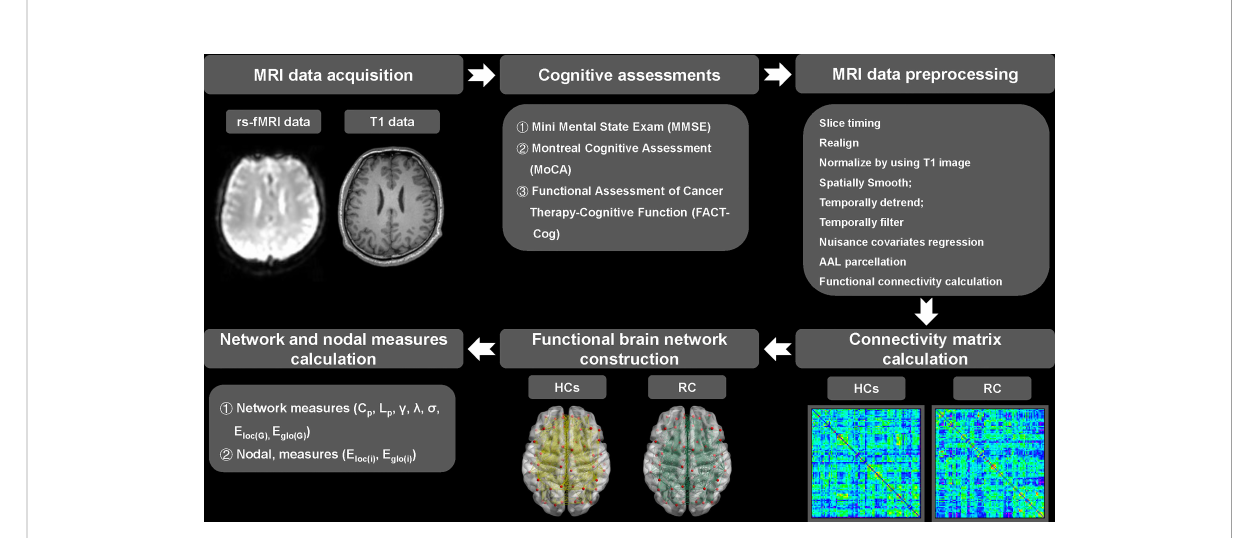
FIGURE 1 Pipeline of MRI data acquisition, preprocessing, functional brain network construction and topological measures calculation. RC, rectal cancer; HCs, healthy controls. g , normalized clustering coef fi cient; l , normalized characteristic path length; s , small-worldness. C p , clustering coef fi cient of network; L p , characteristic path length of network; E loc(G) , local ef fi ciency of network; E glo(G) , global ef fi ciency of